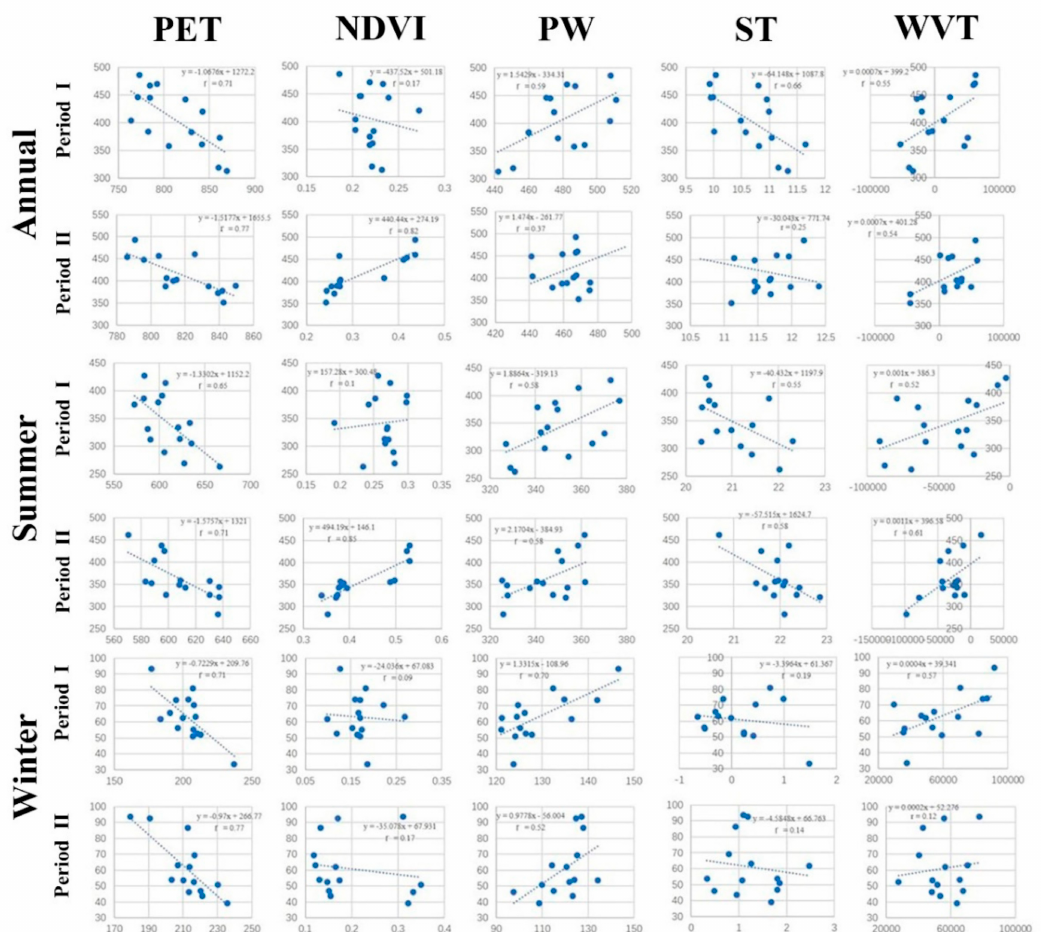
Figure 8. The correlation analysis of factors to precipitation before and after GFGP.